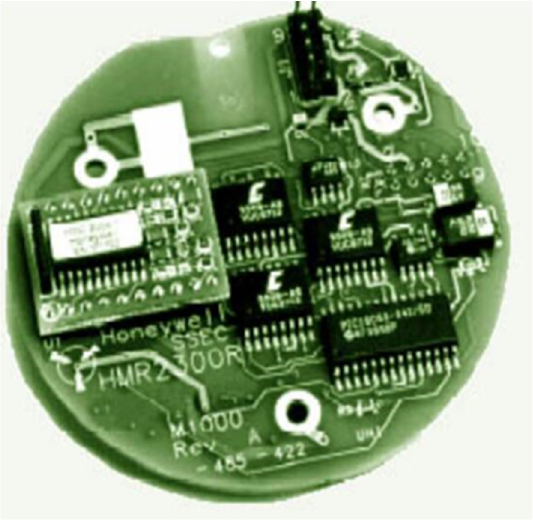
Figure 2. HMR2300R three axis strapdown magnetometer and carrier plate.